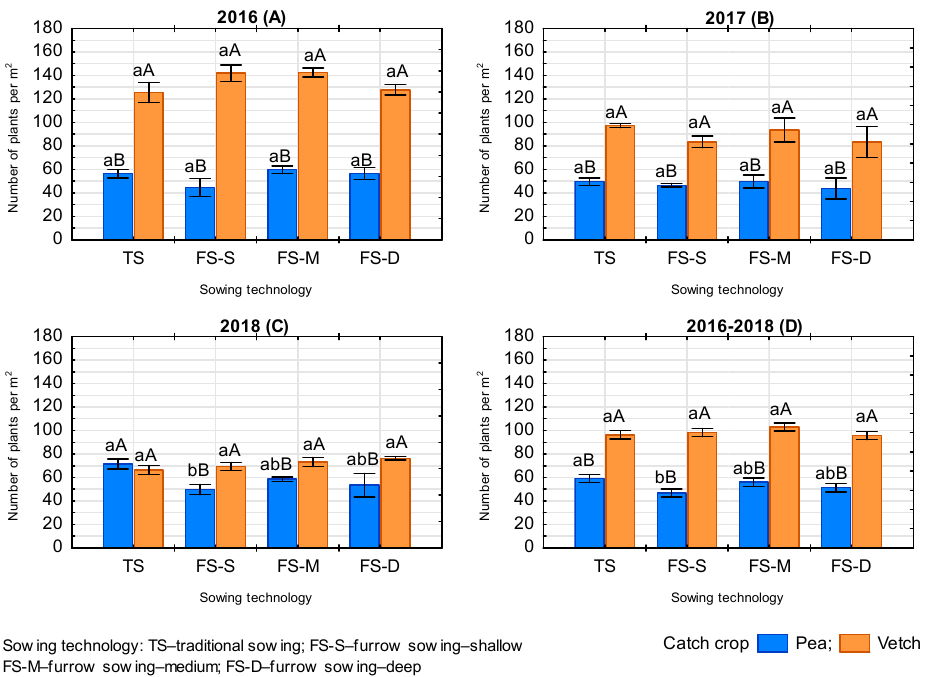
Figure 8. Interaction between factors in shaping the plant density 10 days after sowing seeds [pcs · m − 2 ]. a,b—homogenic groups HSD ( p = 0.05) interaction for sowing method/species (the differences between the four methods of sowing separately for pea and for vetch). A,B—homogenic groups HSD ( p = 0.05) interaction for species/sowing method (differences between pea and vetch for each sowing method).